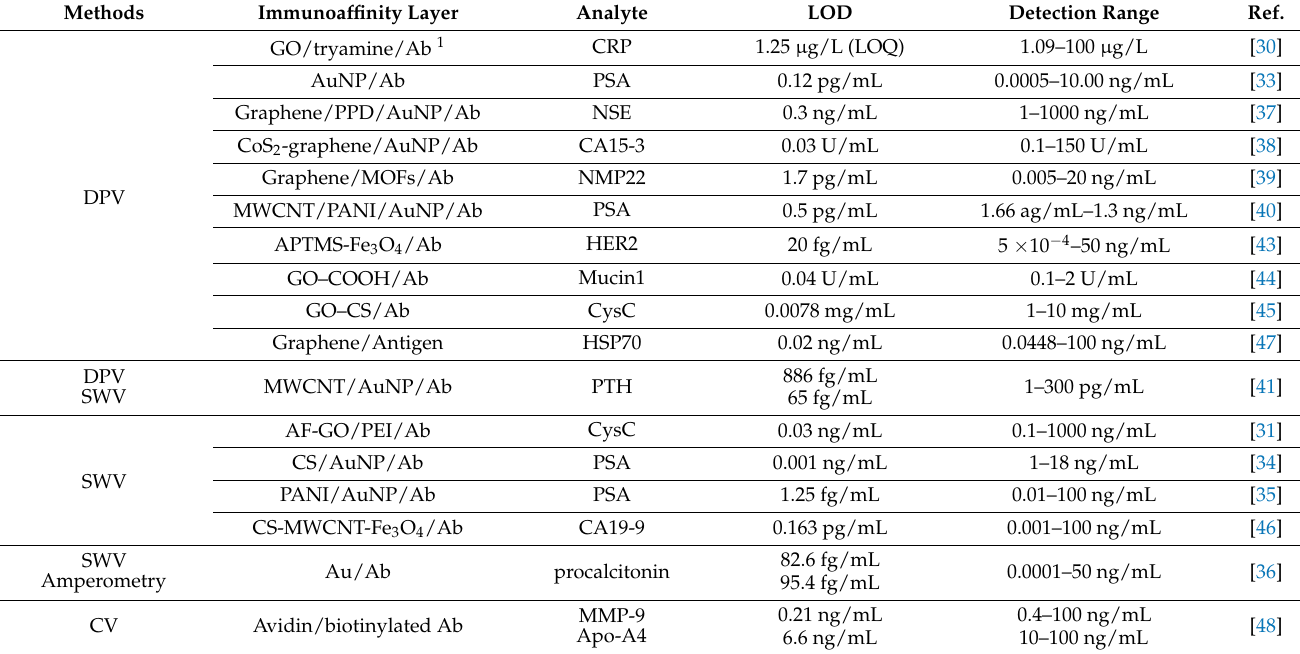
Table 1. Examples of electrochemical